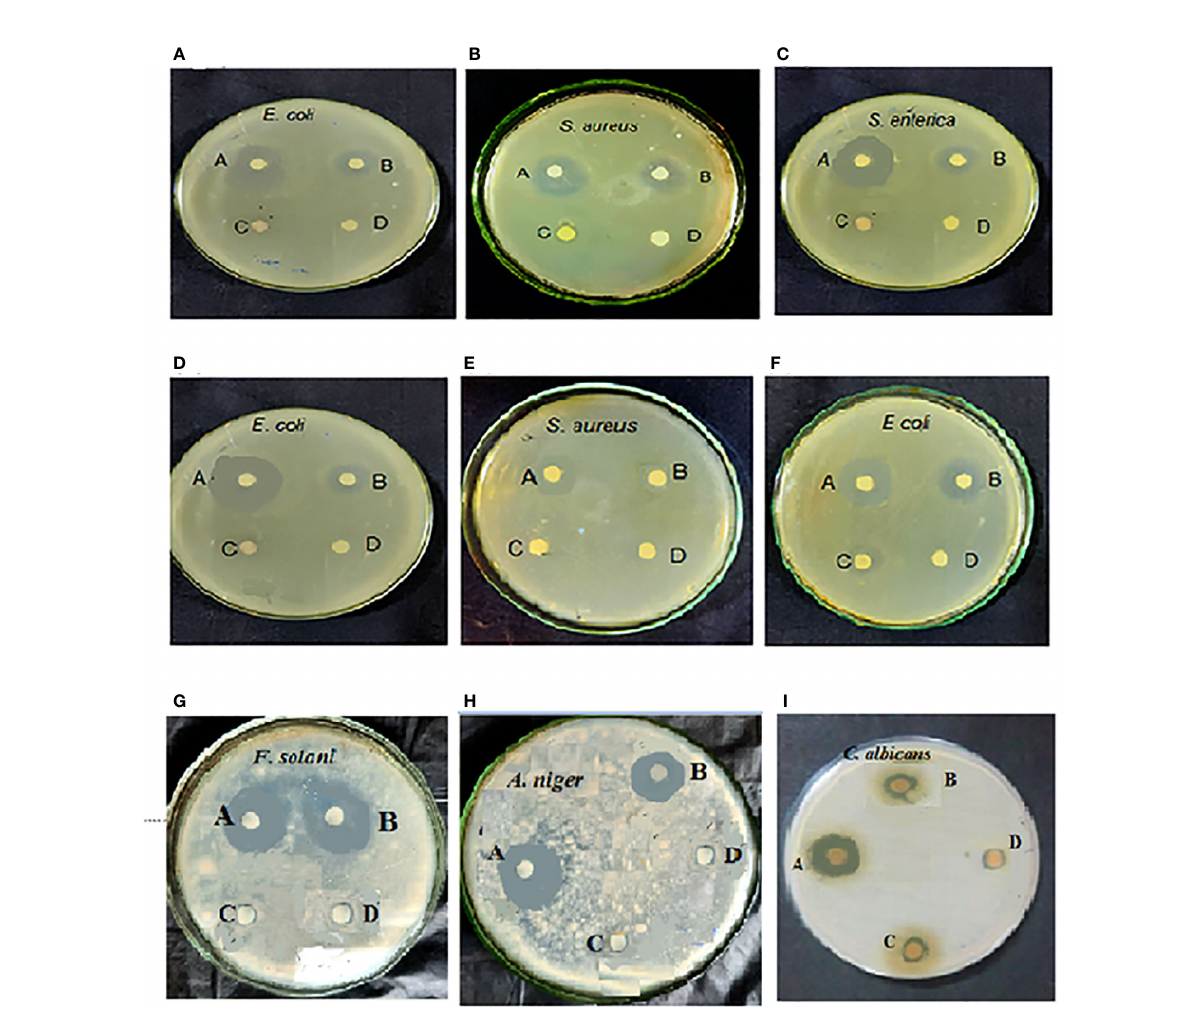
FIGURE 8 Antimicrobial (antibacterial and antifungal) activity of the Au-NPs of C. trinodis (A – C, I) , Cystoseira myrica (D, E, G, H) , and C. prolifera (F) . Letters on the Petri dish: (A) Au-NPs, (B) ampicillin or fuconazole, (C) chloroauric acid, and (D) ethanolic